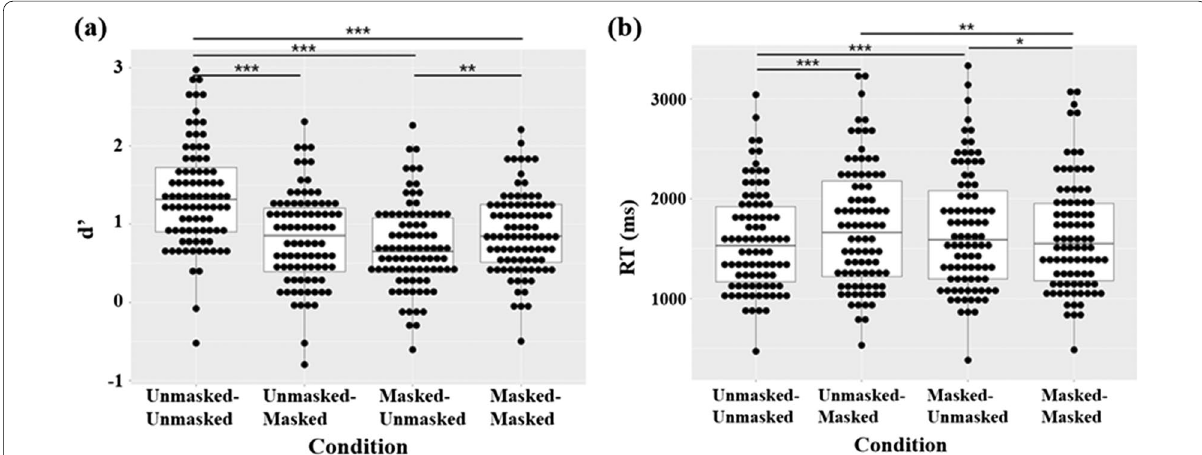
Fig. 1 a Participants’ d ′ in different mask conditions (unmasked–unmasked: Faces were unmasked during both learning and recognition. Unmasked–masked: Faces were unmasked during learning and masked during recognition. Masked–unmasked: Faces were masked during learning and unmasked during recognition. Masked–masked: Faces were masked during both learning and recognition). b Participants’ RT in ms in different mask conditions (* p < .05, ** p < .01, *** p < .001, paired t